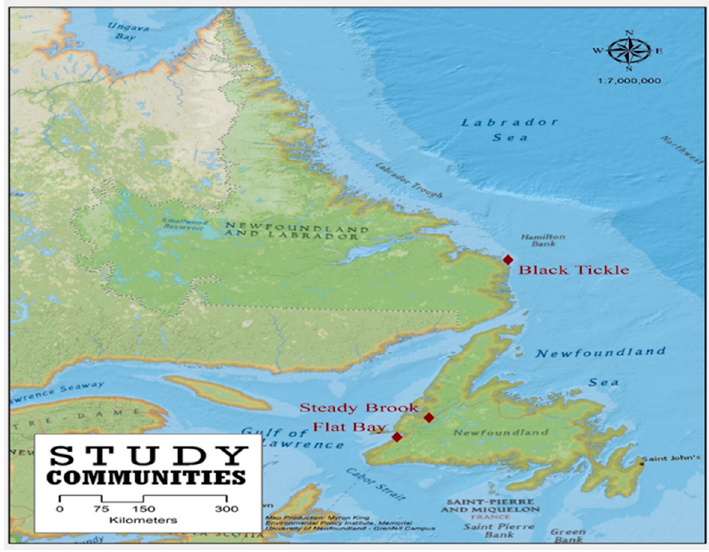
Figure 1. Source: Myron King, Environmental Policy Institute, 2016 [28].